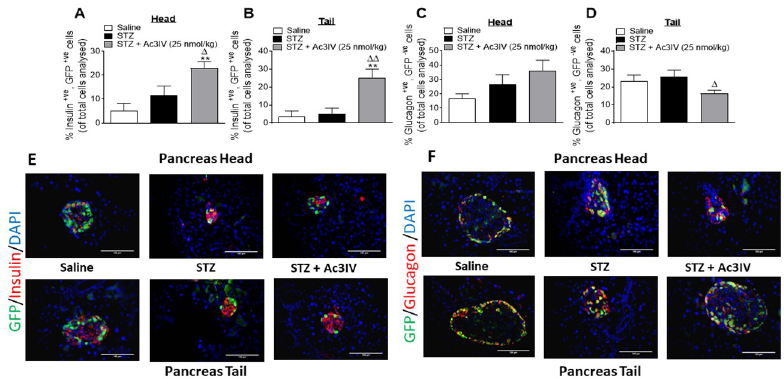
Fig 8. Effects of Ac3IV treatment on pancreatic islet cell lineage in STZ—diabetic Glu CreERT2 ; Rosa26-eYFP mice. Parameters were assessed following 12 days twice-daily treatment with saline (0.9% NaCl) vehicle or Ac3IV (25 nmol/ kg bw, i.p.) in STZ-diabetic Glu CreERT2 ; Rosa26-eYFP transgenic mice. Numbers of insulin +ve , GFP +ve (A,B) and glucagon +ve , GFP -ve (C,D) islet stained cells in the head (A,C) and tail (B,D) of the pancreas are shown as percentages of total cell counts. Representative images (40X) of islets from both the head and tail of the pancreas depicting co- localisation of GFP (green) with either insulin or glucagon (red) are shown in panels E&F. Values are mean ± SEM for n = 6 mice. �� p < 0.01 compared to saline vehicle. Δ p < 0.05 and ΔΔ p < 0.01 compared to STZ-diabetic controls.